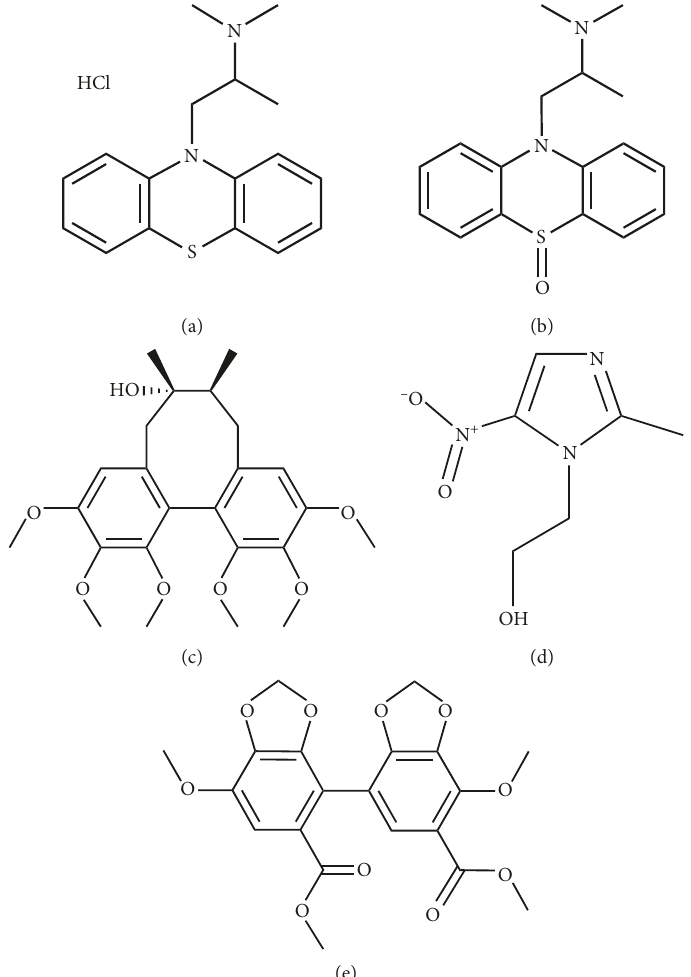
Figure 1: Chemical structure of (a) promethazine hydrochloride, (b) PMZSO, (c) schisandrin, (d) metronidazole, and (e)